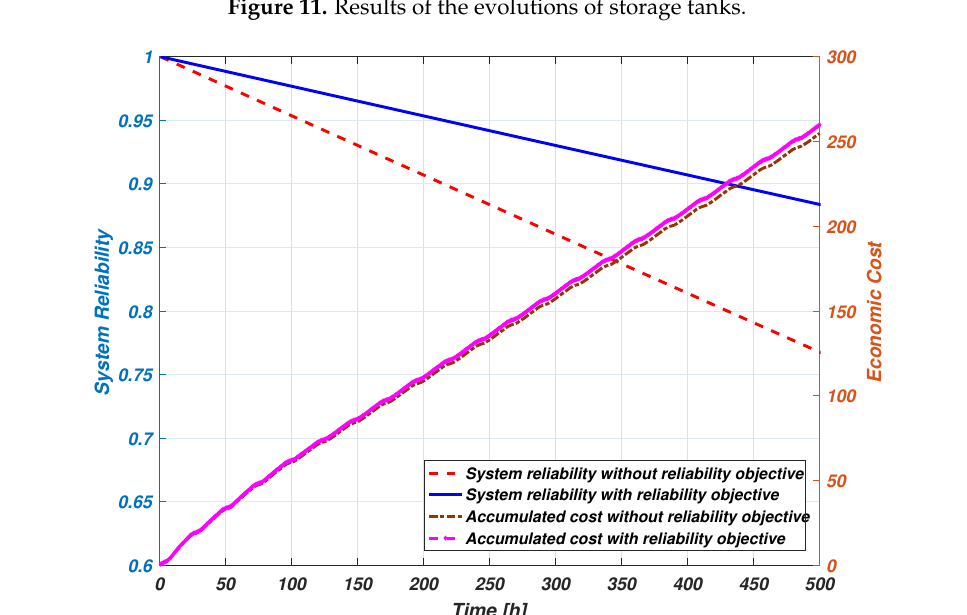
Figure 11. Results of the evolutions of storage tanks.